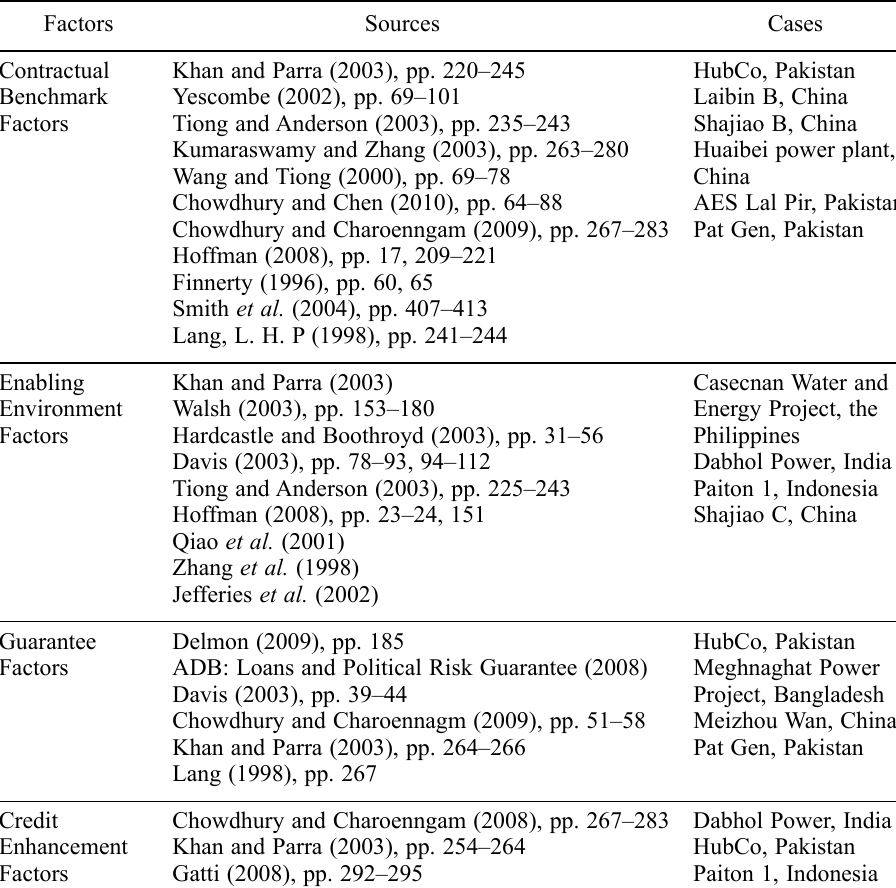
Table 1. Factors and their sources for establishing SPV in